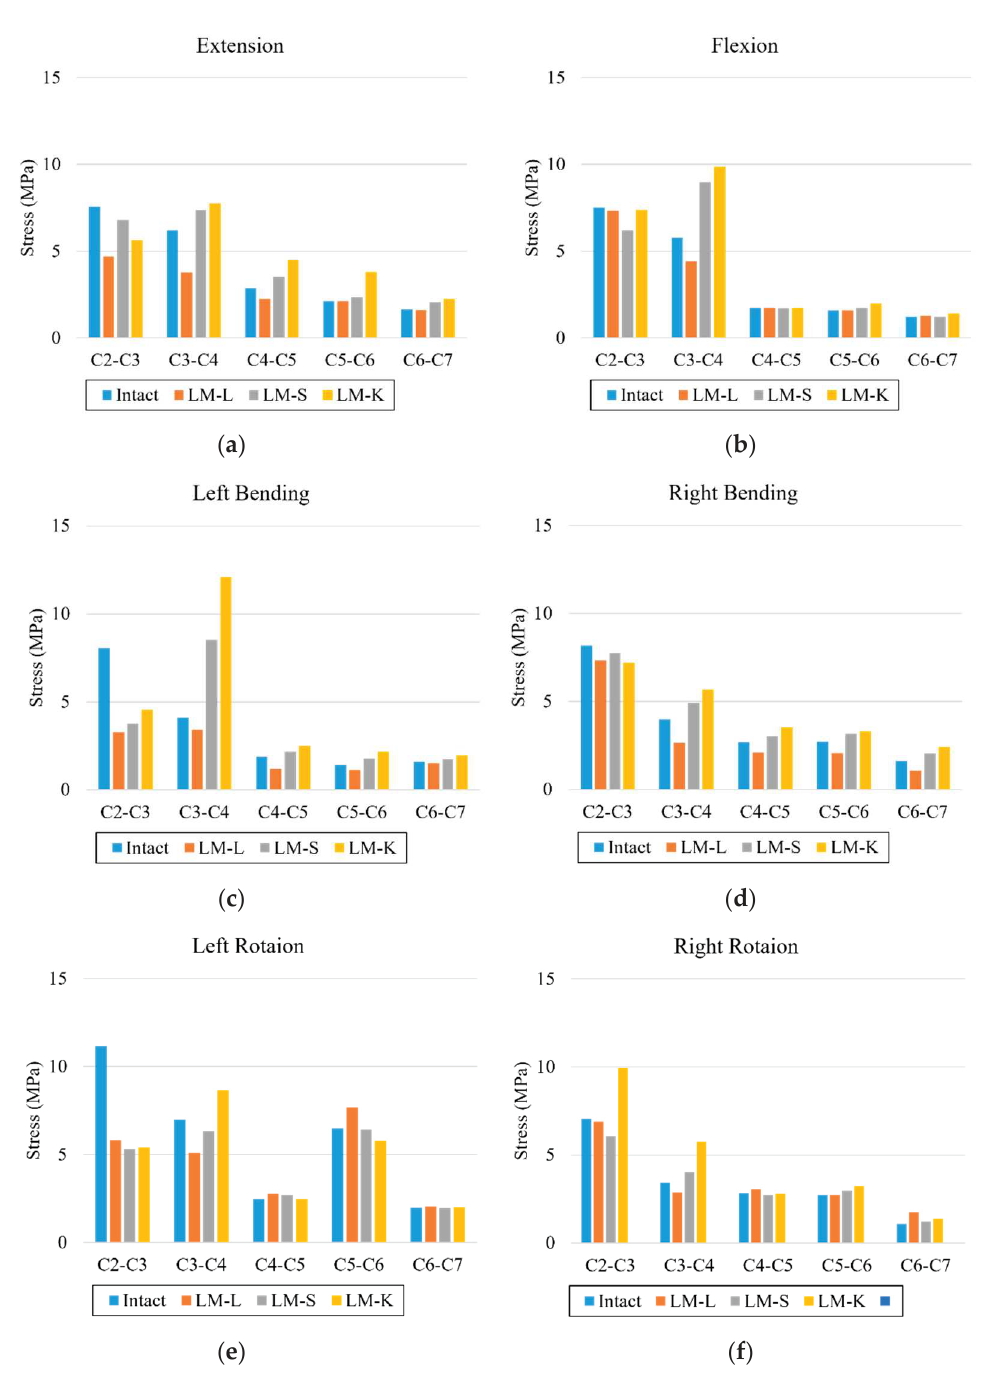
Figure 3. Annulus pressure: ( a ) extension, ( b ) flexion, ( c ) left bending, ( d ) right bending, ( e ) left rotation, and ( f ) right rotation. The vertical axis is stress (megaPascal; MPa); the horizontal axis is each intervertebral level.